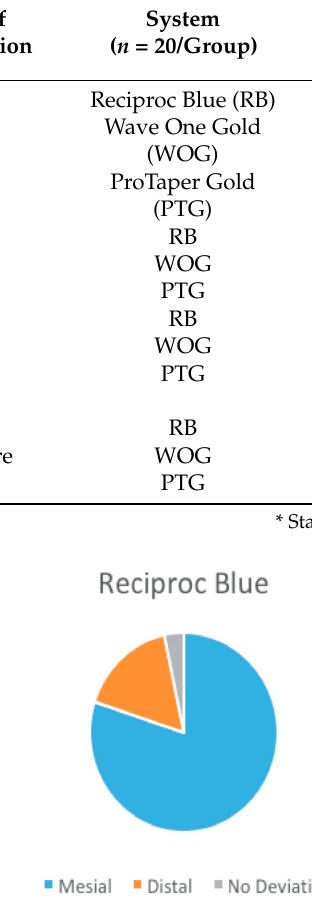
Figure 3. Direction of the mesio-distal transportation for Reciproc Blue, ProTaper Gold, and WaveOne Gold.